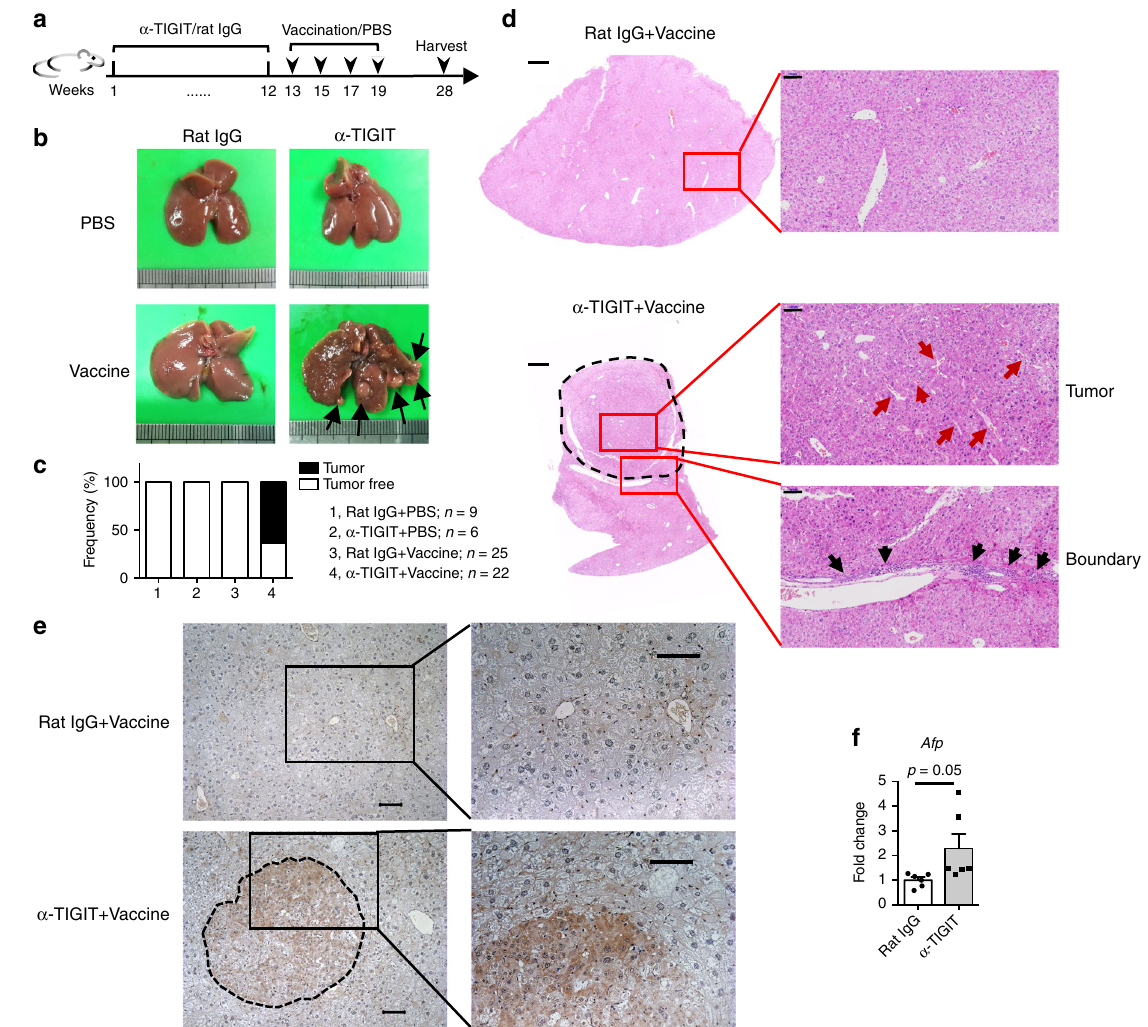
Fig. 2 HBsAg vaccination combined with TIGIT blockade induces HCC in HBs-tg mice. a – d 2-month-old HBs-tg mice were intraperitoneally injected with 200 μ g α -TIGIT mAb or rat IgG weekly for 3 months, then followed by intramuscular injection with 1 μ g HBsAg vaccine or 50 μ l PBS biweekly with four consecutive repetitions. All mice were harvested 2 months after the fi nal vaccination. a Schematic of antibody treatment and vaccination in mice. b Representative pictures of the liver at harvest as indicated in ( a ). Black arrows indicate tumor nodules. c The percentage of mice with tumorigenesis. Data are pooled from three independent experiments. d Representative pictures of H&E staining of liver tissue sections of the mice in ( a ). The right pictures show the magni fi ed views of the areas indicated by the squares in the left pictures (scale bars: left, 500 μ m; right, 100 μ m). Red arrows indicate typical trabecular HCC features. Black arrows indicate in fl ammatory cell in fi ltration. Data are representative of three independent experiments. e Representative images showing immunohistochemical AFP staining of paraf fi n-embedded liver sections from mice treated with α -TIGIT antibodies or rat IgG. The right pictures show the magni fi ed views of the areas indicated by the squares in the left pictures. Scale bars, 50 μ m. f Quantitative RT-PCR analysis of hepatic Afp gene of mice treated with rat IgG or α -TIGIT after HBsAg vaccination ( n = 6 in each group). Statistically signi fi cant differences between the groups are presented as the mean ± SEM (two-tailed unpaired Student ’ s t -test). Data are representative of two independent